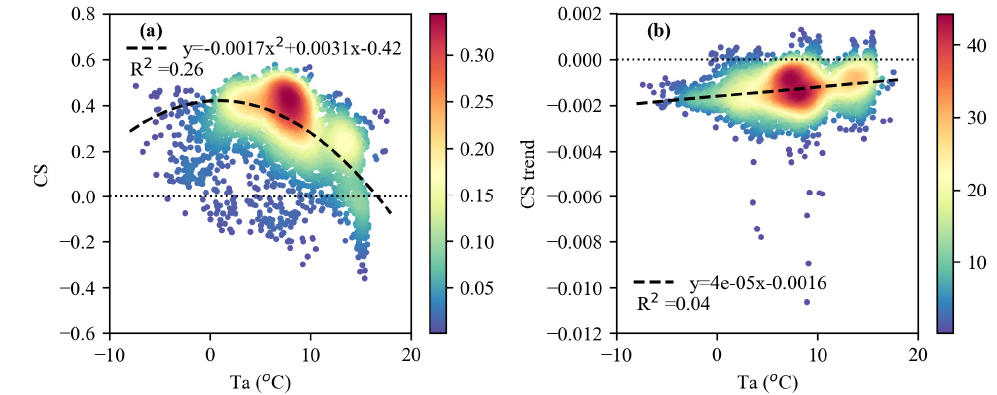
Figure 10. ( a ) Variation in evapotranspiration-precipitation CS and ( b ) its trend with air temperature (shades of color indicate the density of the points).